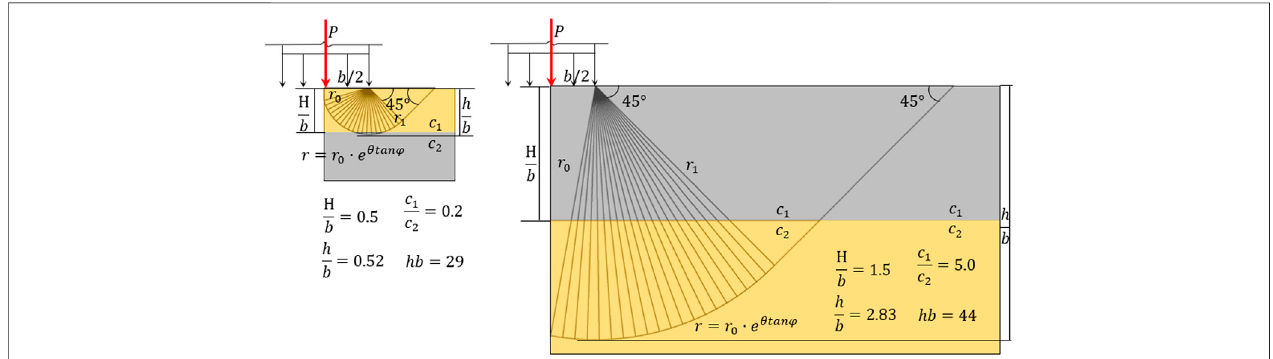
FIGURE 7 | Calculation model of bearing capacity of the two-layer clay